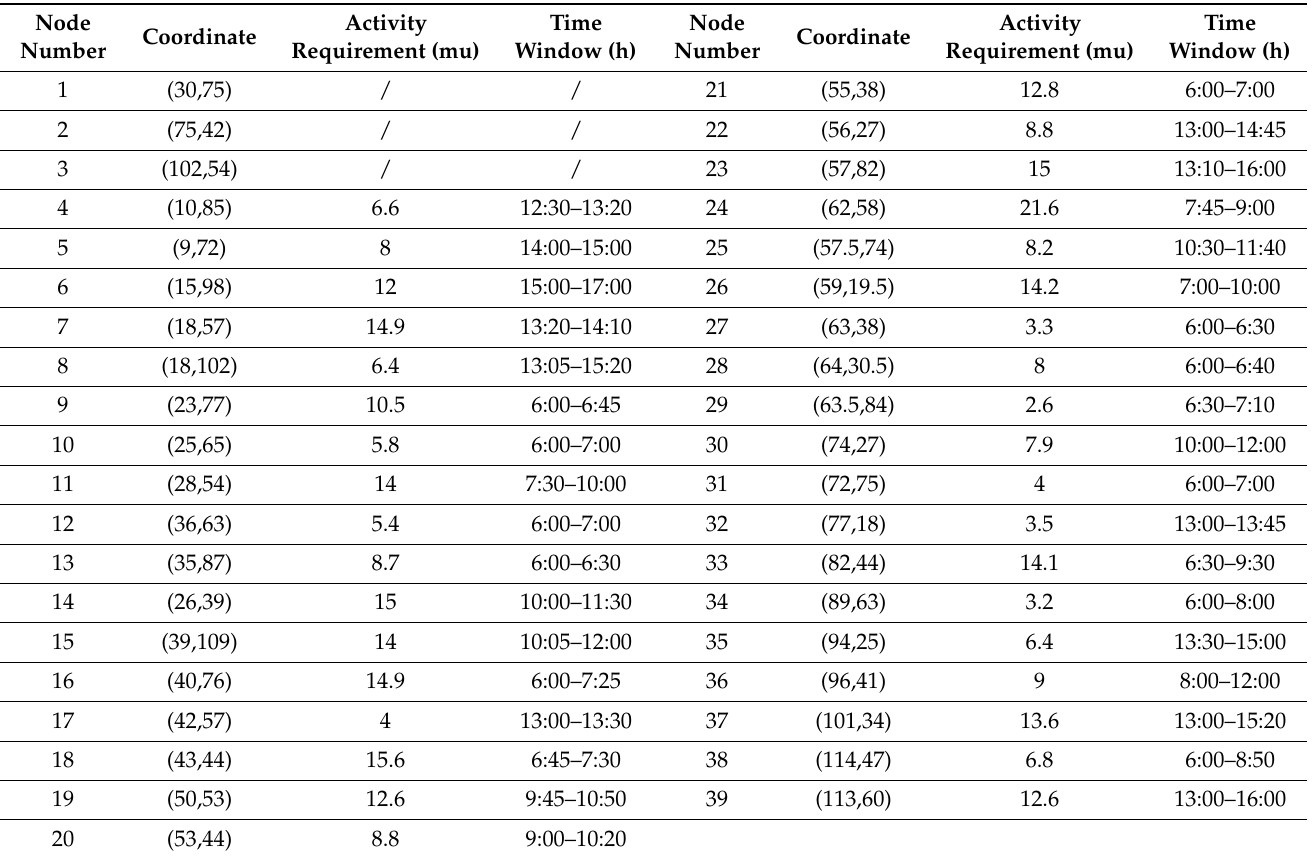
Table 6. Coordinates and operation information of cooperatives and work